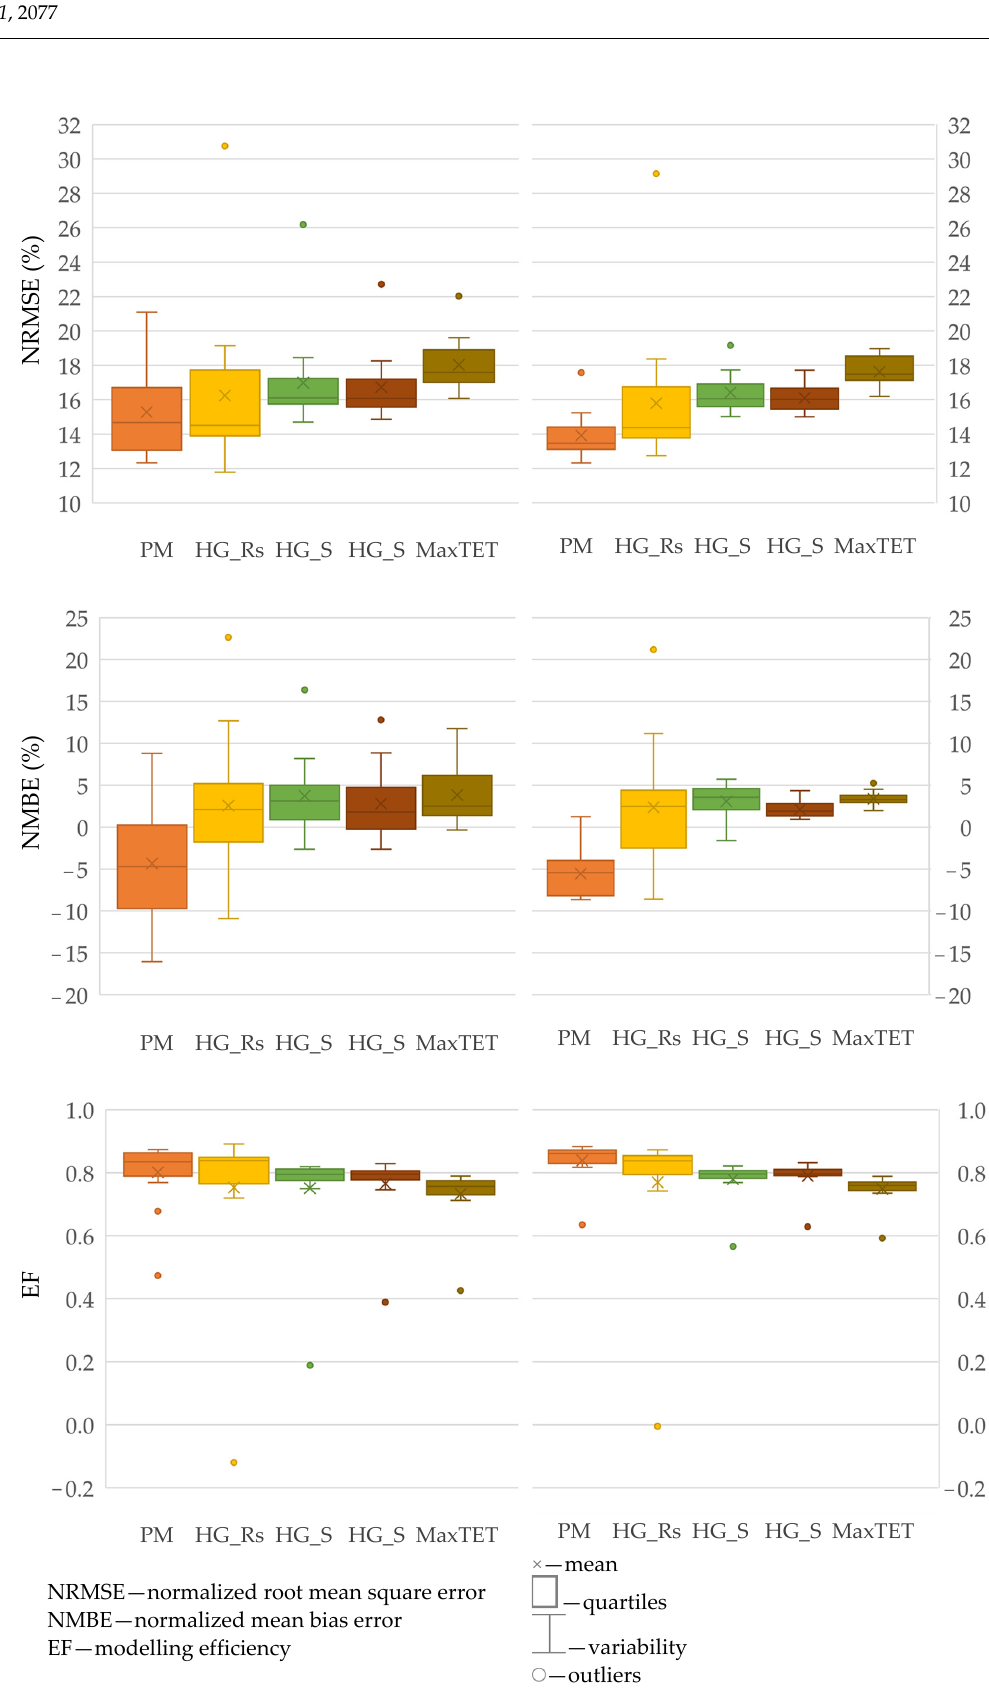
Figure 2. Box plots (Box and whiskers) of normalized root mean square error, normalized mean bias error and modelling efficiency when comparing daily ETo-PM estimated from observed weather data with ETo estimated from regionally (on the left) and locally (on the right) bias corrected NASA POWER data using all methods and relative to all